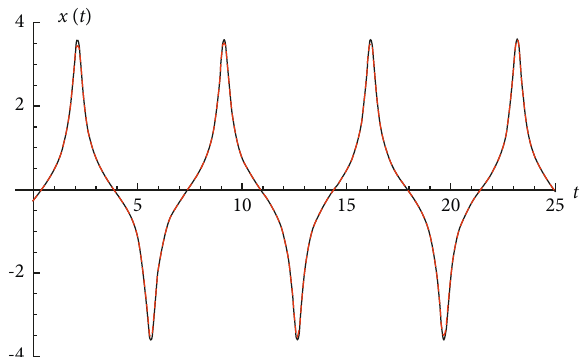
Figure 1: Comparison between the exact solution and the Run- ge–Kutta numerical solution for i.v.p.